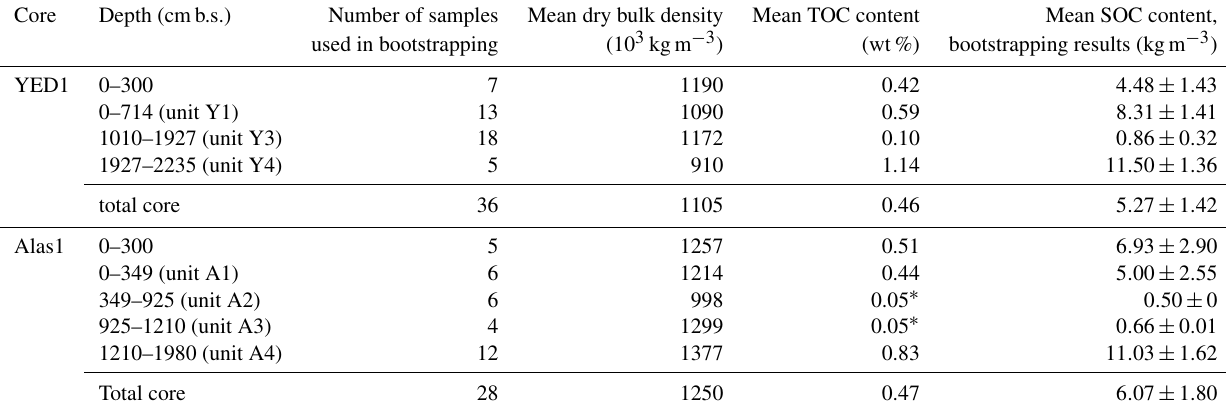
Table 2. SOC contents for the individual core units, based on the bootstrapping results; calculations were carried out for 1m 2 . The measure- ment data used in the bootstrapping approach (bulk density and TOC density) are provided in the data sheet in the PANGAEA repository. ∗ refers to samples with a TOC content < 0 . 1wt%. For the organic carbon pool calculations, we assumed a TOC of 0.05wt% for these samples. Note: we excluded unit Y2 from the